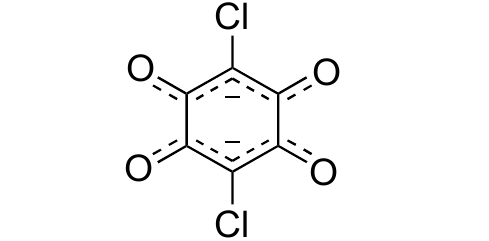
Table 2. Summary of SHAPE parameters 1 for lanthanide centers in the series of the dinuclear complexes 1 – 5